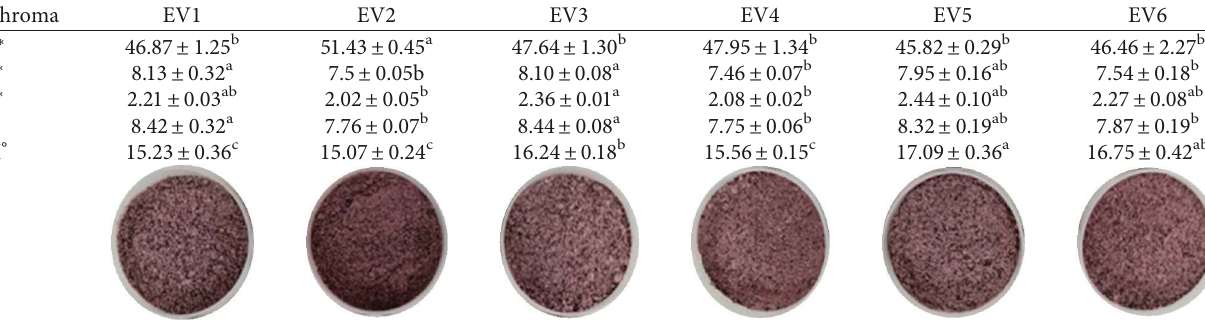
Table 5: Color analysis of powdered composites obtained by different process conditions in conventional kilns with air circulation.